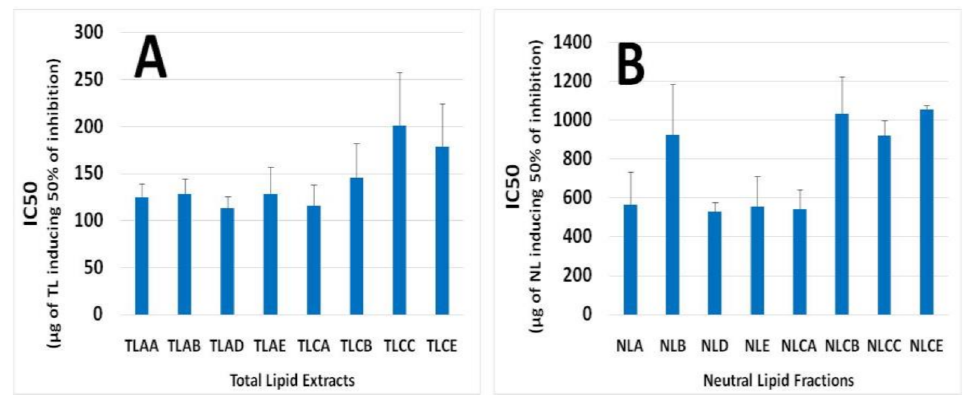
Figure 2. Anti-platelet activities (IC50 values) of TL ( A ) and NL ( B ) extracts from different apple juice (AA, AB, AD and AE) and cider samples (CA, CB, CC and CE) against PAF-induced human platelet aggregation. Abbreviations: TL: Total lipids; NL: Neutral lipids; AA and CA: apple juice and cider from apples with low content in tannins (Jonagold), respectively; AB and CB: apple juice and cider from apples with moderate content in tannins (Dabinett); AE and CE: apple juice and cider from apples with high content in tannins (Aston Bitter); AD: commercially found apple juice (relevant to the apple juice AA of the Jonagold variety); CC: commercially found cider ‘ Con’s Irish Cider ® ’ (produced by fermentation of a mixture of the aforementioned three different apple juice types in a ratio of 55% Jonagold, 35% Dabinett and 10% Aston